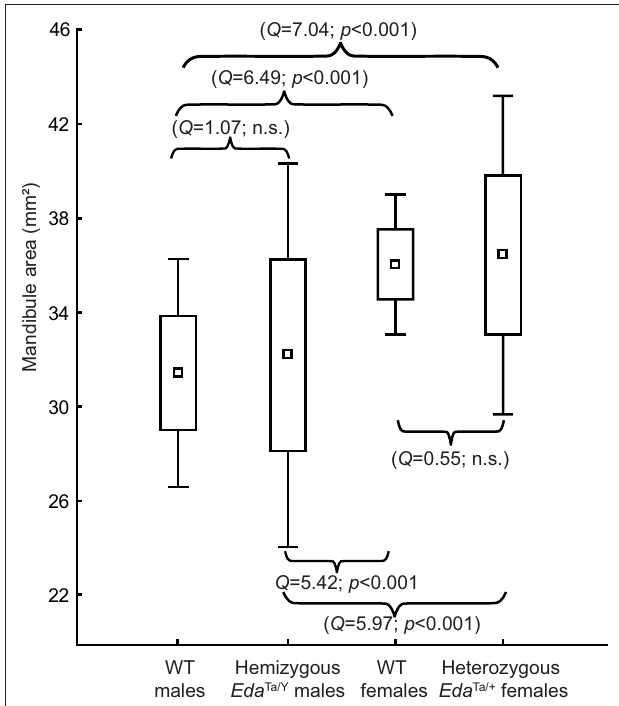
Figure 7 | Size variation of the mandible in wild-type, hemizygous Eda Ta/y and heterozygous Eda Ta/y mice. Comparable magnitude of size differences were depicted between WT males-WT females and between hemizygous Tabby males–heterozygous Tabby females. Results of the post hoc pairwise between-group comparisons (Tukey’s test) are reported. Box indicates mean (square) ±1 SD; outliers correspond to minimum